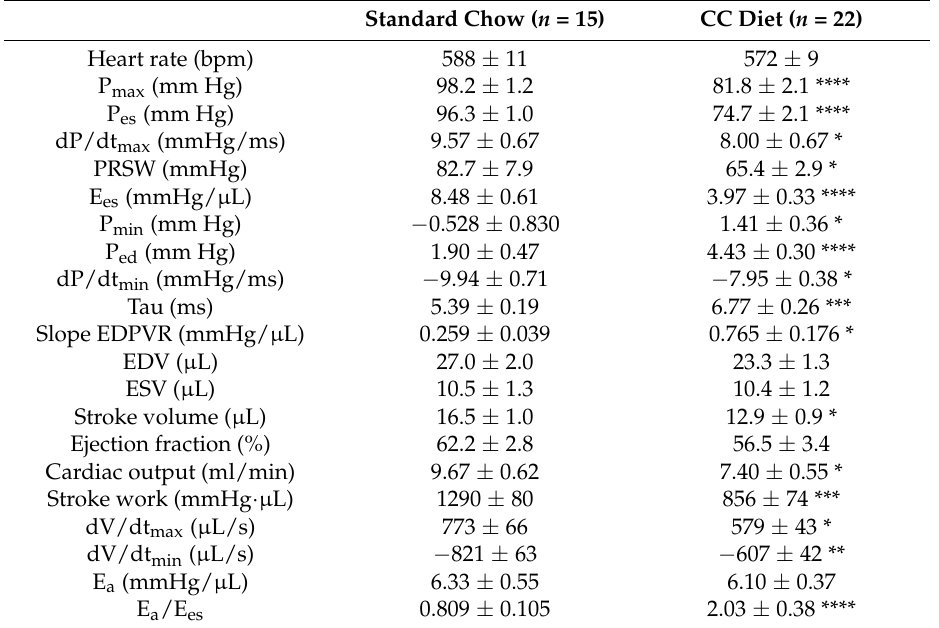
Table 1. Overview of hemodynamic data in C57BL/6 mice fed standard chow and C57BL/6 mice fed the CC